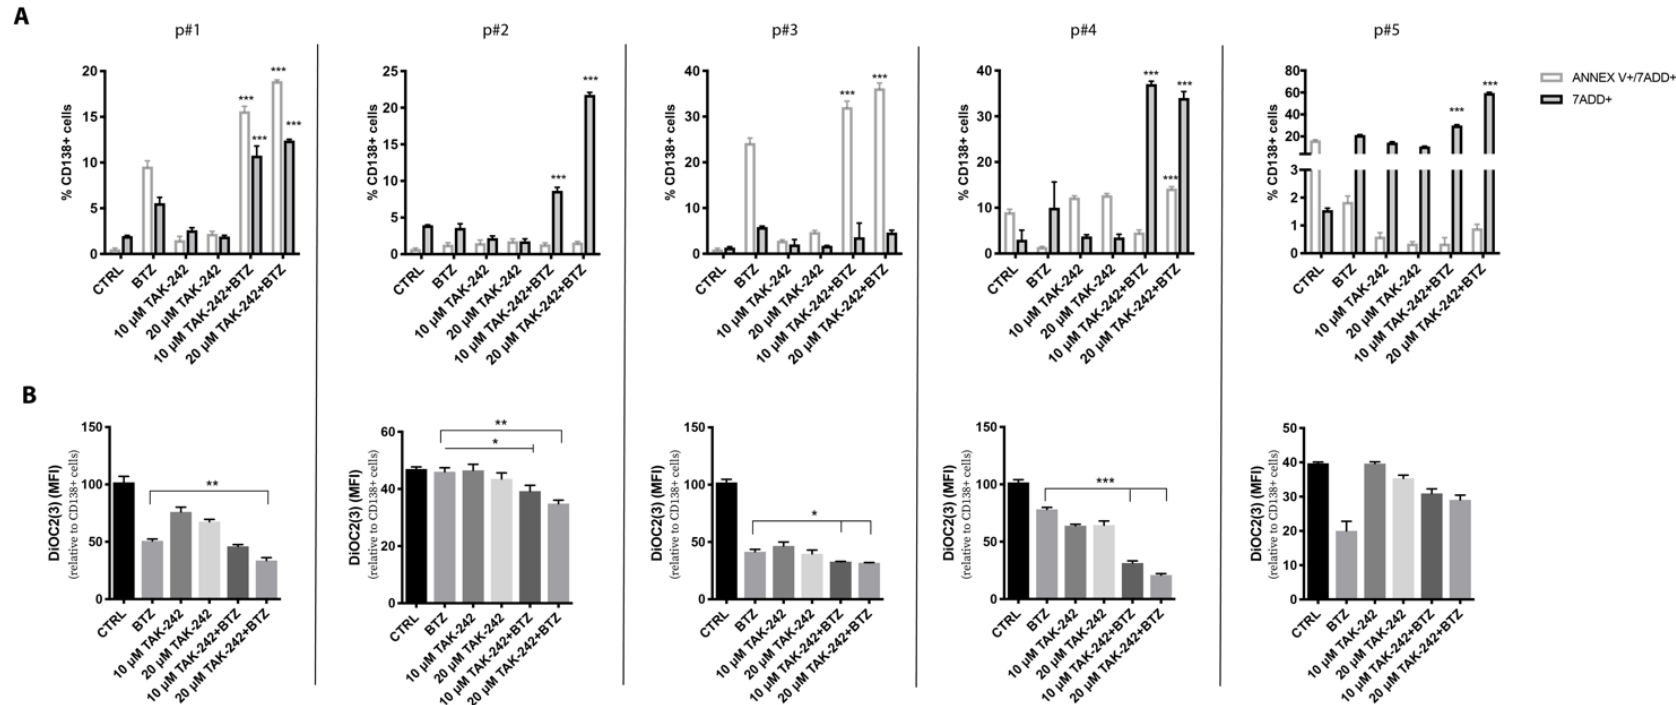
Figure 7. Targeting TLR4 signaling and proteasome activities resensitized to BTZ myeloma PCs cells from refractory patients. CD138+ cells obtained from refractory MM patients were treated with BTZ (5 nM) in combination or not with TAK-242 (10-20 μ M). ( A ) The percentage of CD138+/annexin V+/7-ADD+ or CD138+/7ADD+ cells were estimated by flow cytometry 48h post-treatment. ( B ) Mitochondrial membrane potential was assessed 24h post-treatment analyzing MFI of DiOC2(3) staining on CD138+ cells by using flow cytometry. Bars indicate the standard error means. * p < 0.05; ** p < 0.01; *** p < 0.001.